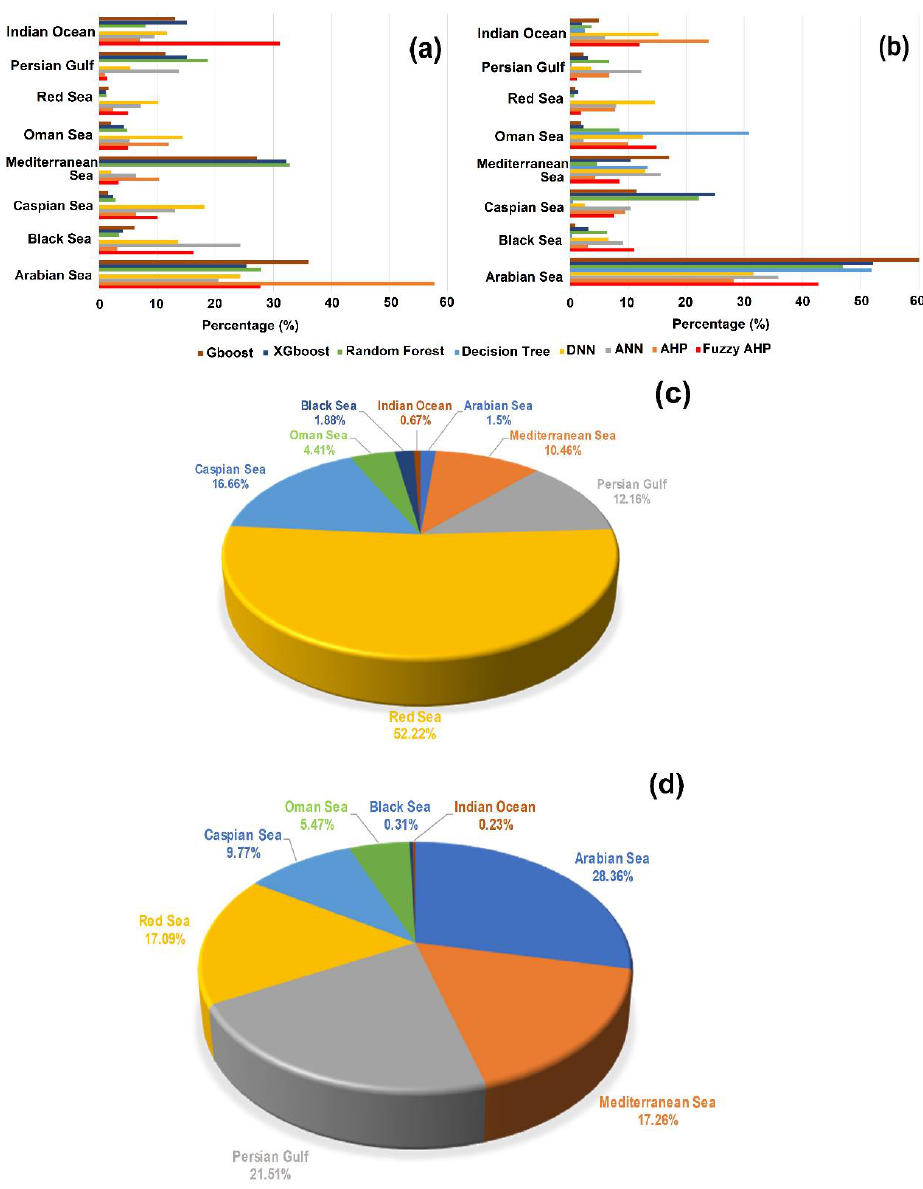
Figure 6. Fractional importance of various moisture sources that influence precipitation across Iran during dry ( a ) and wet ( b ) periods. The moisture uptake percentage from various sources for Iran during the dry ( c ) and wet (d) periods from 1981 to 2015.